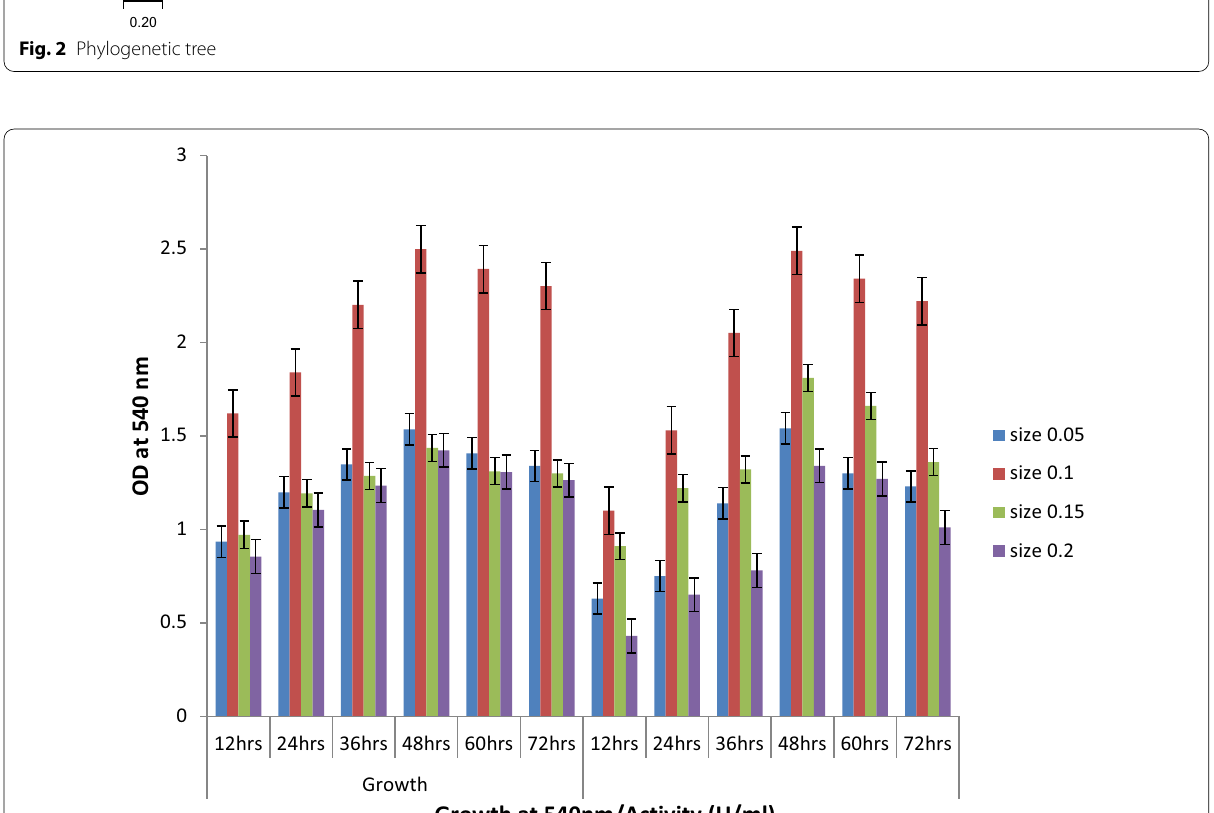
Fig. 3 Effect of inoculum volume on growth and enzyme activity of Lactobacillus fermentum at different incubation